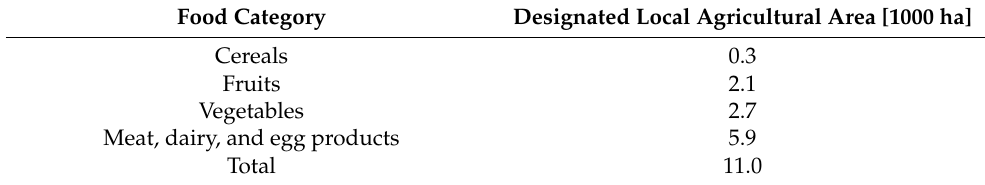
Table 3. Local agricultural area in Qatar in 2016 [36]. Food